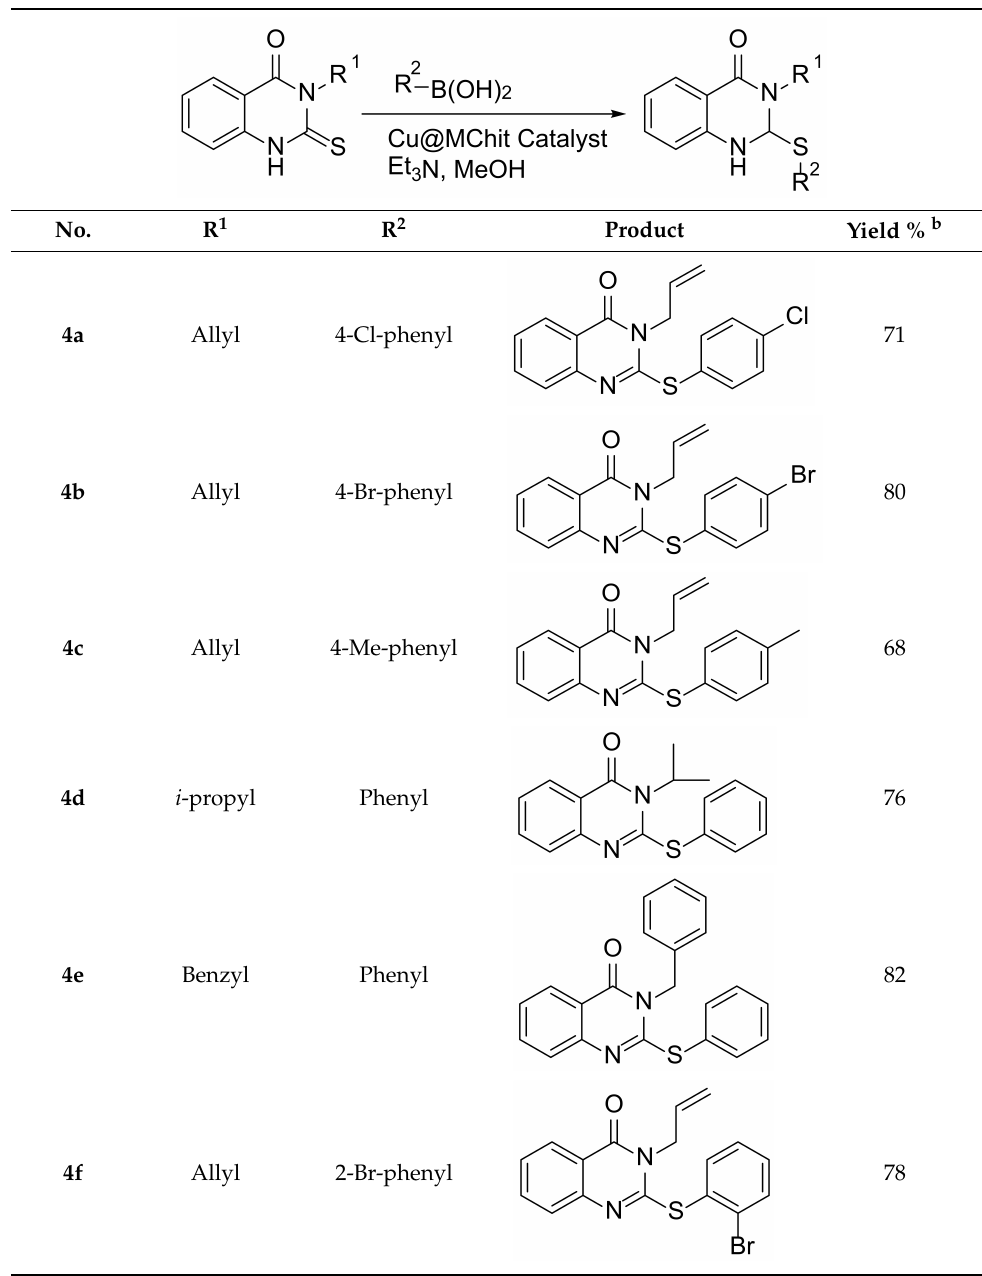
Table 2. Scope and generality of the synthesis of 3-alkyl-2-arylthio-2,3-dihydroquinazolin-4(1 H )-one a .